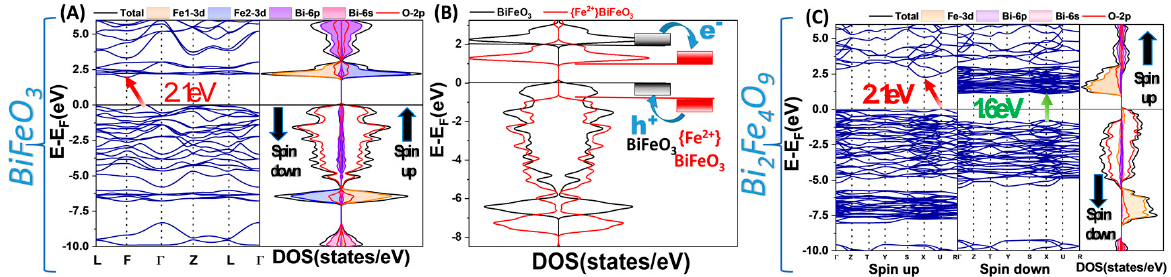
Figure 7. ( A ) Theoretical energy band-structure and DOS of BiFeO 3 . ( B ) DOS for {Fe 2+ }BiFeO 3 (red lines) vs. BiFeO 3 (black lines). ( C ) Theoretical energy band-structure and DOS of ferromagnetic Bi 2 Fe 4 O 9 .